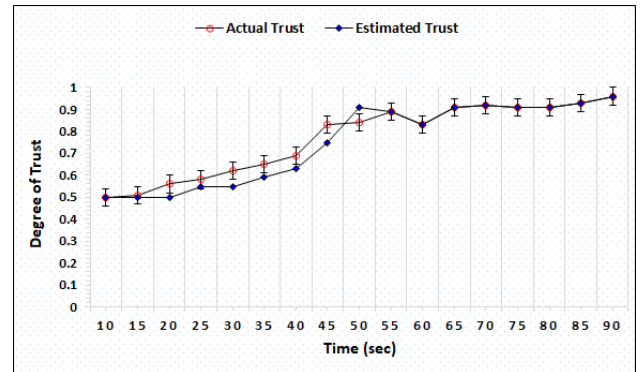
Figure 6. Trust degree of honest sensor.